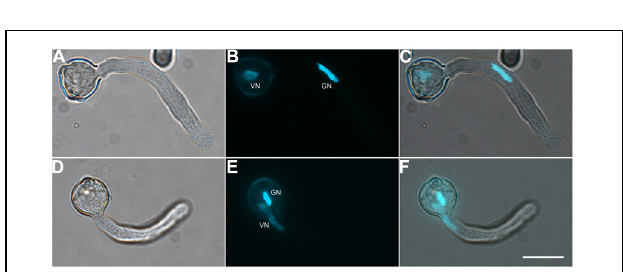
FIGURE 2 | Both vegetative cell nuclei (VN) and GCs can enter the pollen tube first. Pollen germinated for 1 h observed by DIC microscopy (A,D) or after DAPI staining (B,E) . Images were merged (C,F) . DAPI-stained VN and GC nucleus (GN) in (B) and (E) . Scale bar: 20 μ